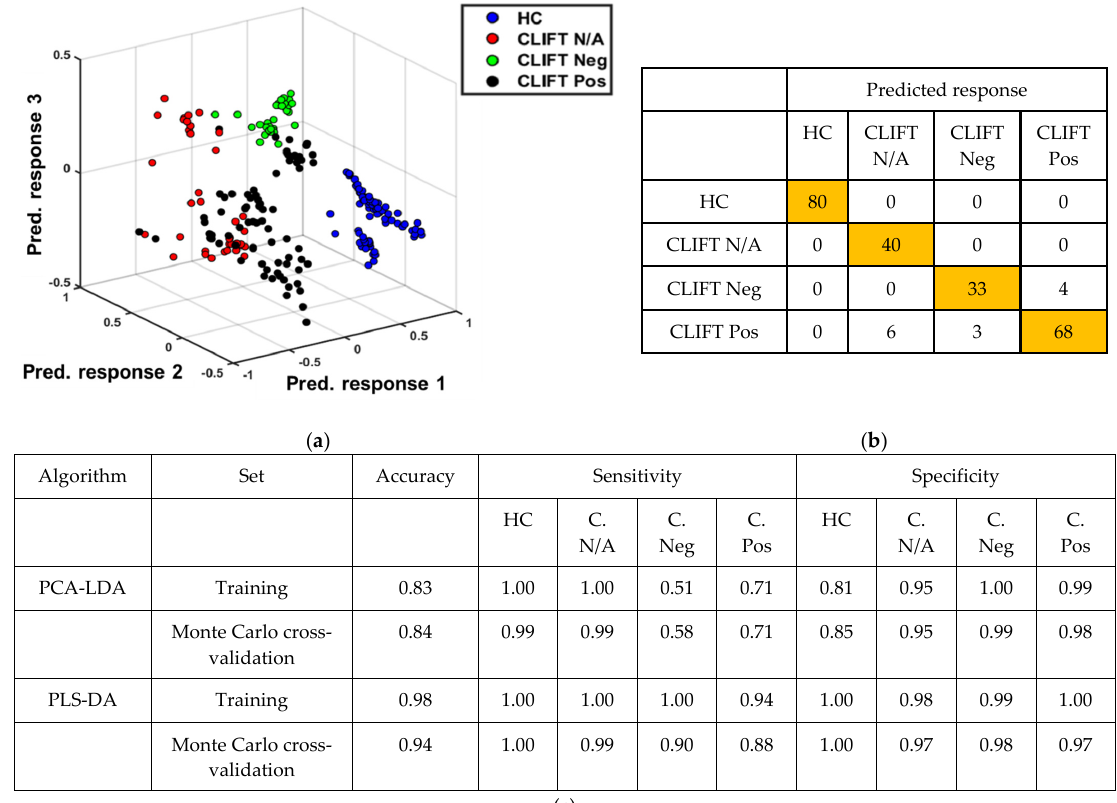
Figure 5. Multivariate analysis of the fingerprint region for SLE subgroups and HCs. ( a ) PLS-DA classification model predicted response for healthy controls (HC), ELIA Neg CLIFT N/A (CLIFT N/A), ELIA Pos CLIFT Neg (CLIFT Neg), ELIA Pos CLIFT Pos (CLIFT Pos). ( b ) Cross-validation confusion table generated from individual spectra; 154 SLE spectra ( n = 8 patients) and 80 HC spec-